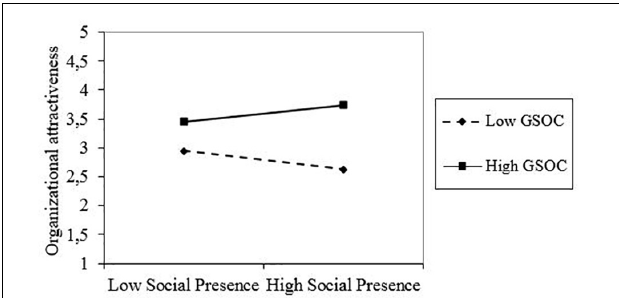
FIGURE 2 | Interaction effect of manipulated social presence and social gratification on organizational attractiveness. GSOC = social gratification. The lines displayed are for the value of 1 SD above and below the mean of the moderator. The slope of the full line is never significant. The dotted line is only significant when the moderator (social gratification) is 1.6 SD below the mean. For this value: gradient of simple slope = –0.50, t = –1.971, p = 0.050 (Dawson, 2013,